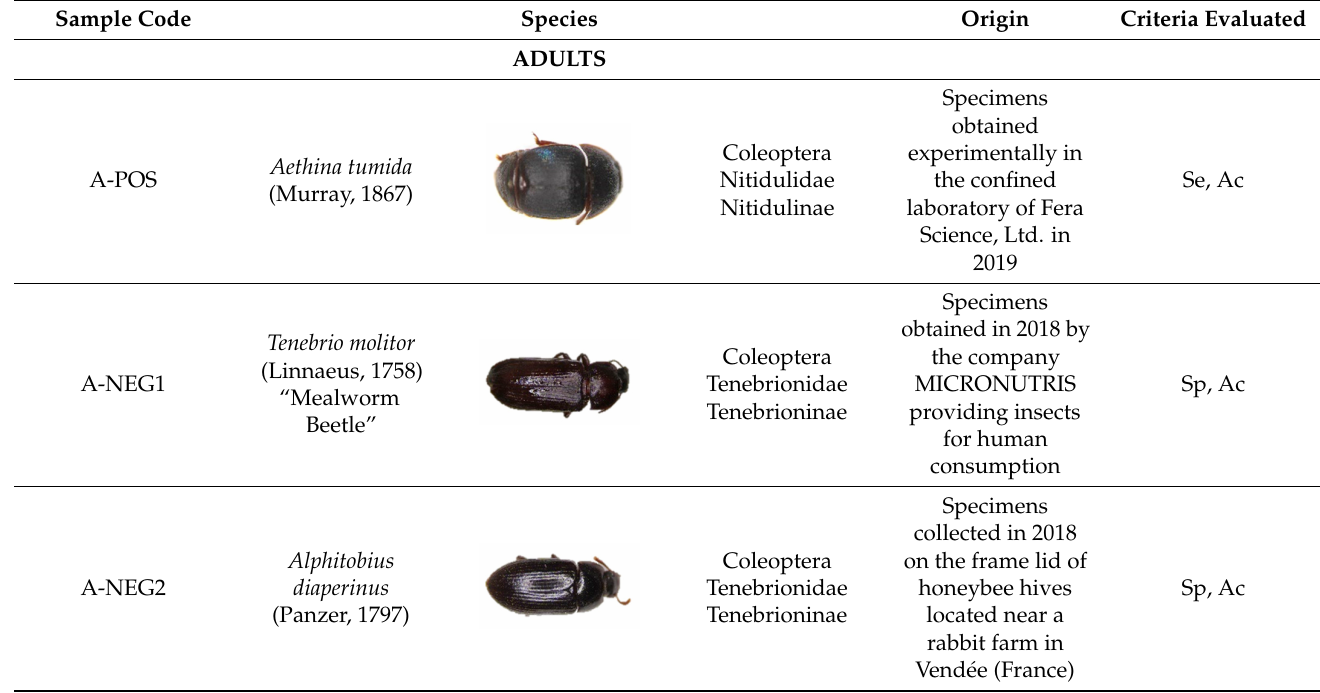
Table 2. Nature and origin of the different specimens included in the sample panel for comparison. (Se: Sensitivity; Sp: Specificity; Ac: